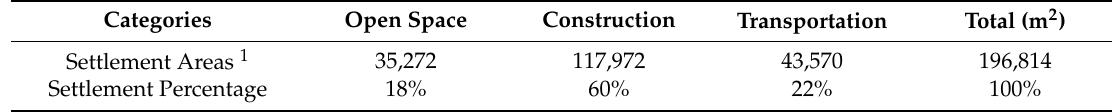
Table 2. Settlement area showing di ff erent land-use patterns within the coastal land area.